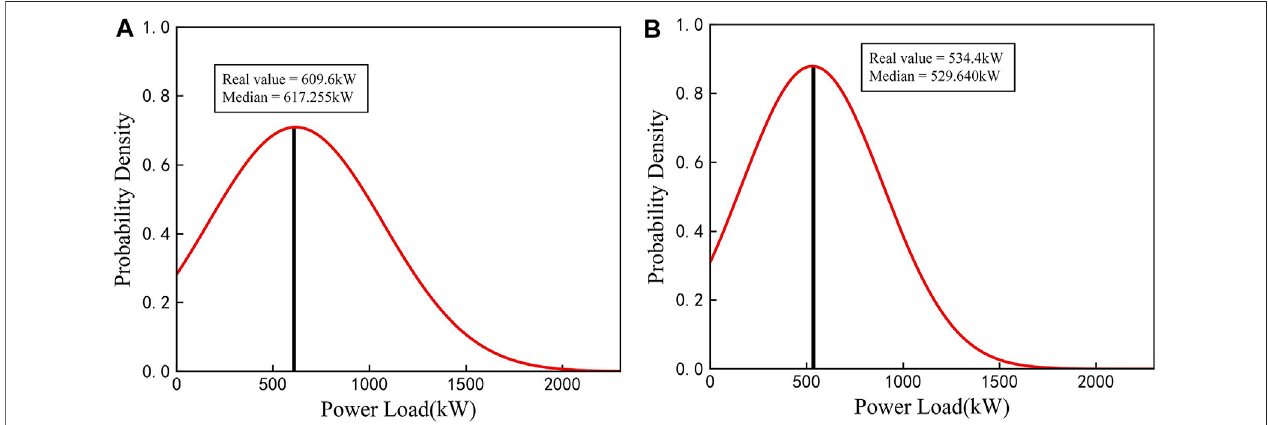
FIGURE 6 | ConvLSTM-MDN model predictive distribution and real values for a day at (A) 8:00 and (B) 16:00 in experiment 1.